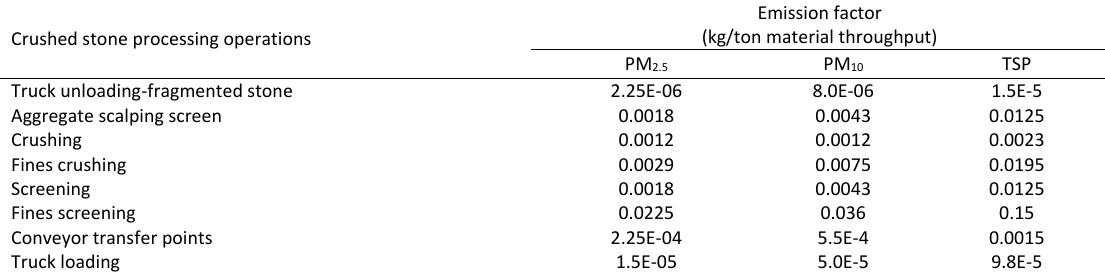
Table 3: Emission factors for crushed stone processing operations (US EPA, 2004) Emission factor (kg/ton material throughput) Crushed stone processing operations